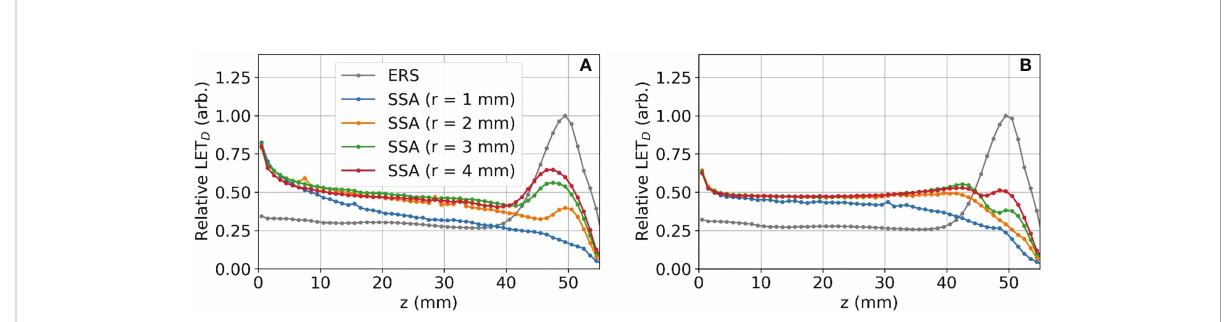
FIGURE 9 The dose-averaged LET integrated along the z-axis for tungsten (A) and nickel (B)